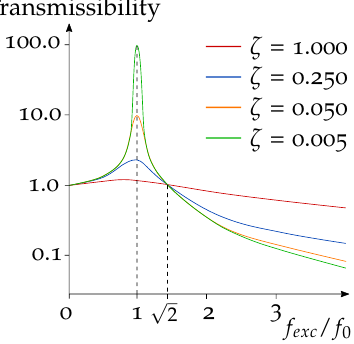
Figure 4. Vibration transmissibility depending on the ratio of the exciting frequency f exc and the eigenfrequency f 0 for different damping ratios ζ (based on [17]).